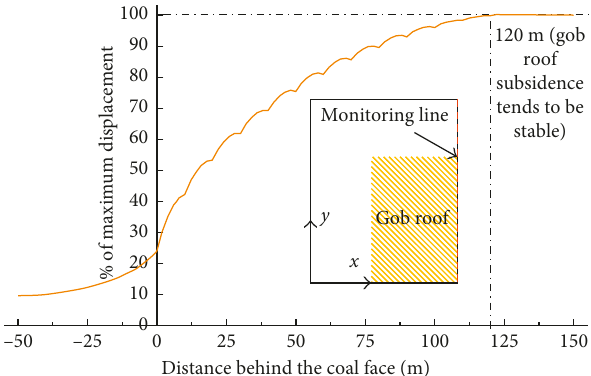
Figure 9: Roof subsidence curve at different distances behind the coal face.